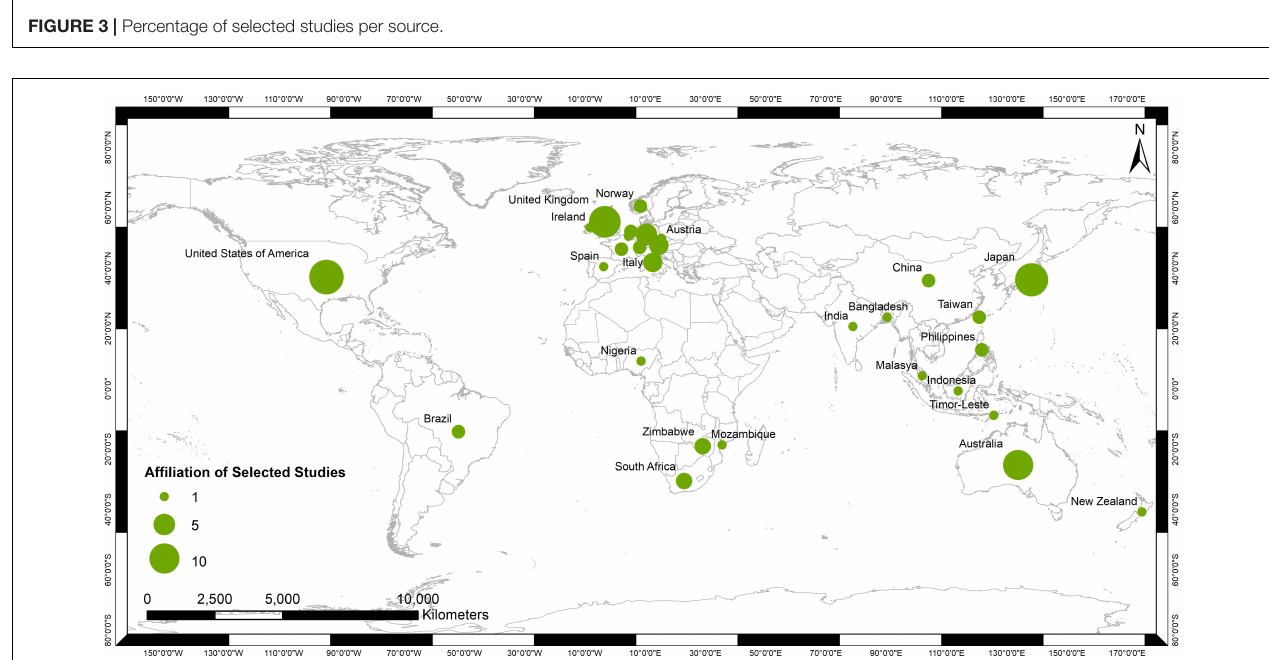
FIGURE 4 | Selected studies per country of